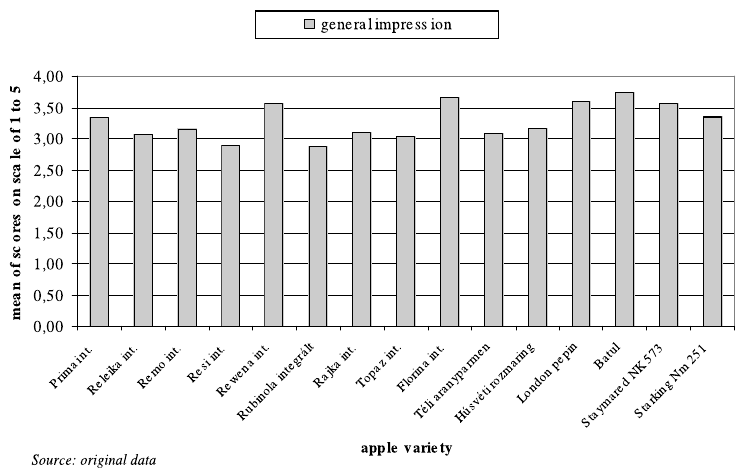
Figure 7: Mean values of scores given to the general impression of the samples